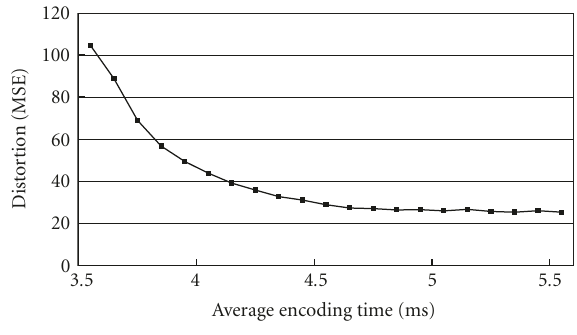
Figure 5: Minimum distortion versus average encoding time.